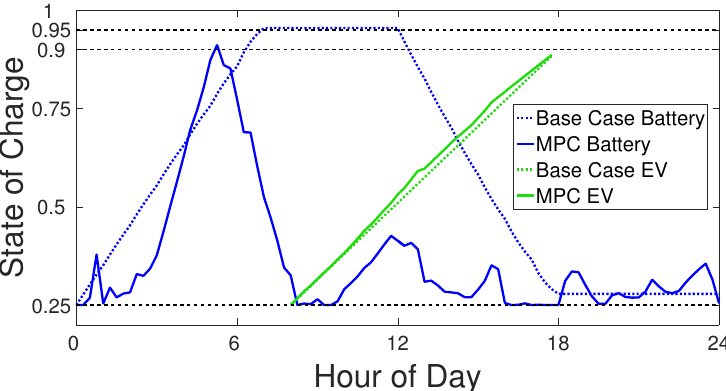
Figure 9. Typical state of charge for the battery storage and EV subsystems under the supervisory MPC system, referenced with the state of charge for the same subsystems in the rules-based base case.